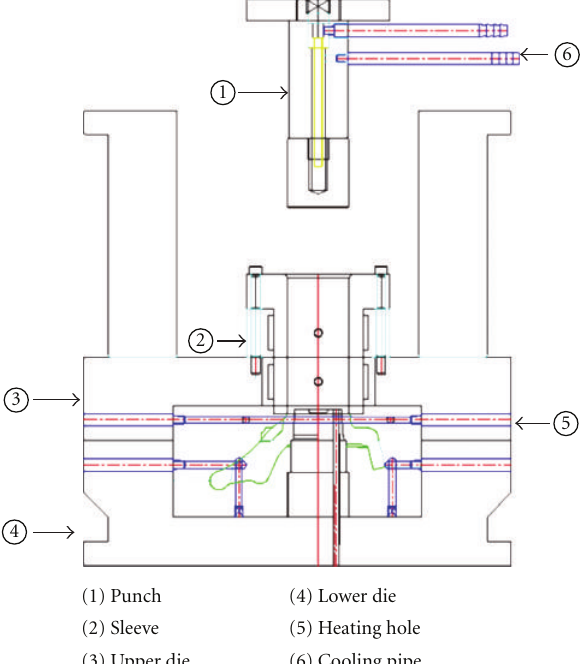
Figure 26: Schematic of indirect-type die set for rheo-forging and product.